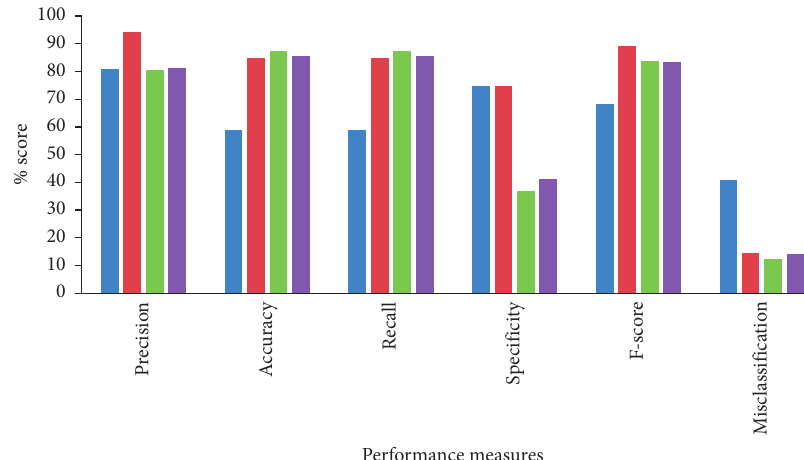
Figure 6: Cross validation-based performance results.